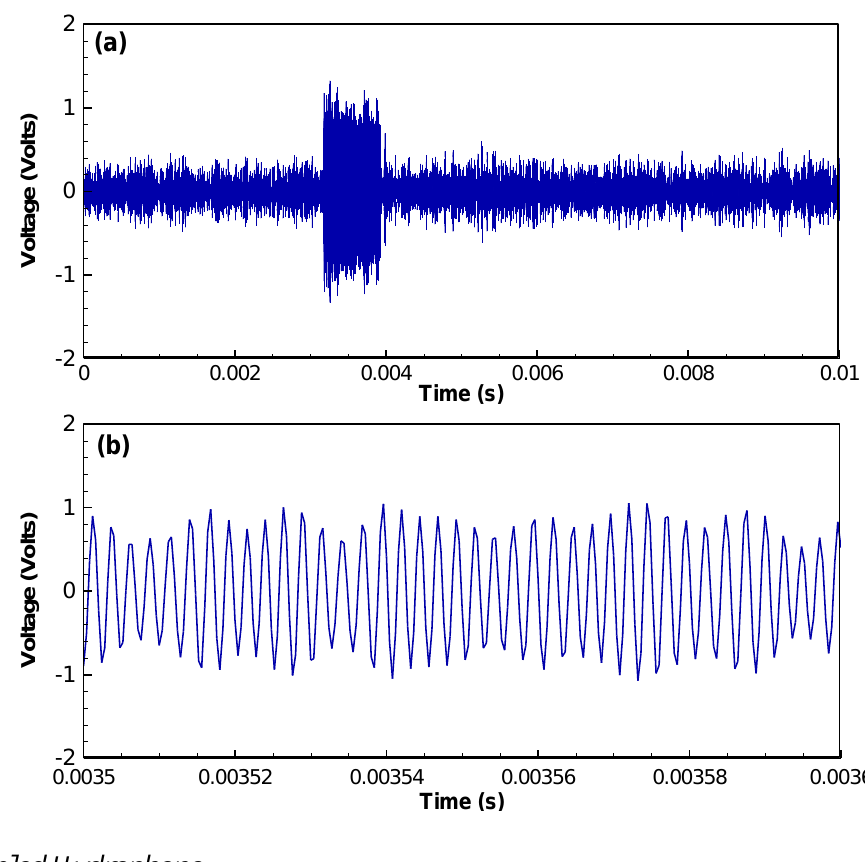
Figure 3. Typical microtransmitter BPSK signal consisting of 310 cycles and 1,860 samples: (a) complete waveform; (b) zoomed-in view for phase change